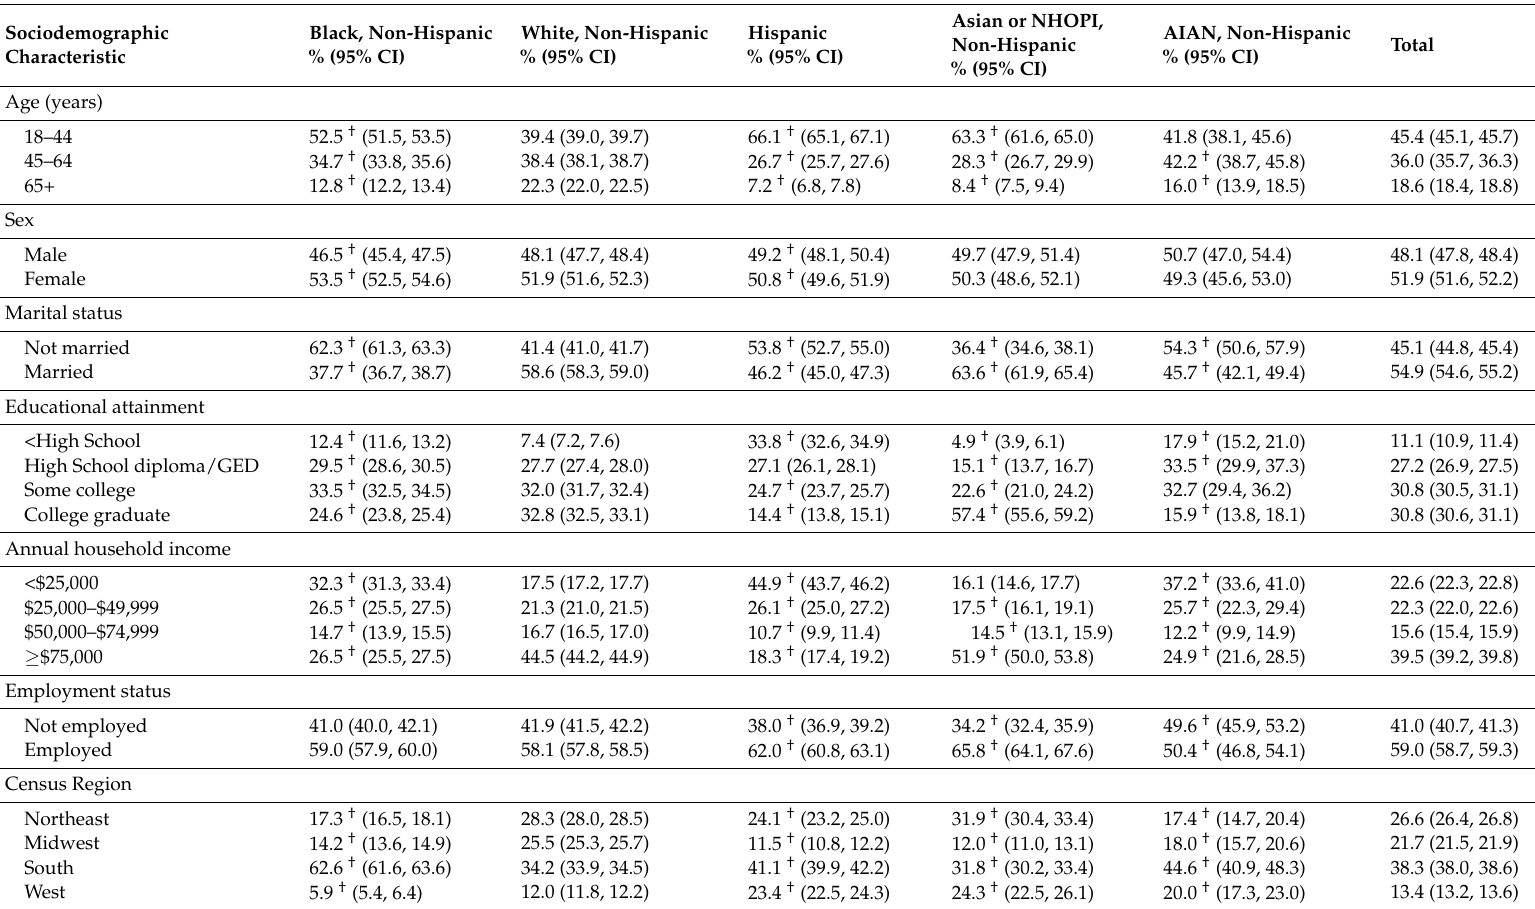
Table 5. Sociodemographic characteristics of large fringe metropolitan dwelling adults * by race and ethnicity: Behavioral Risk Factor Surveillance System, United States,